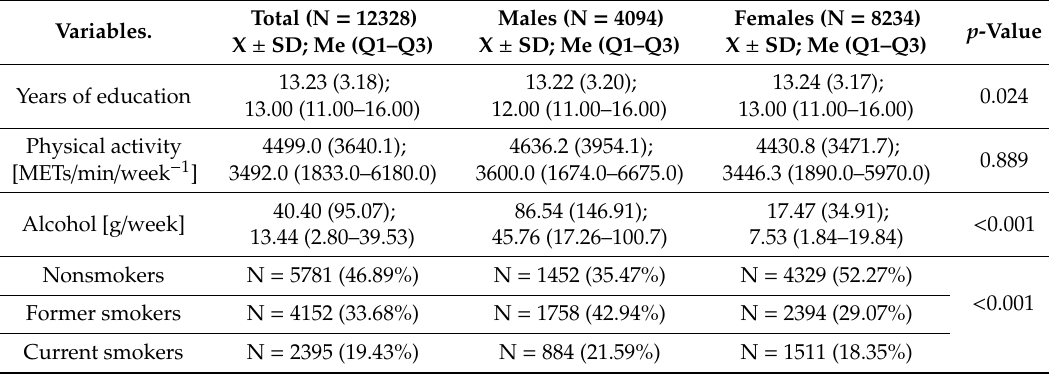
Table 3. Social variables and lifestyle habits of the subject